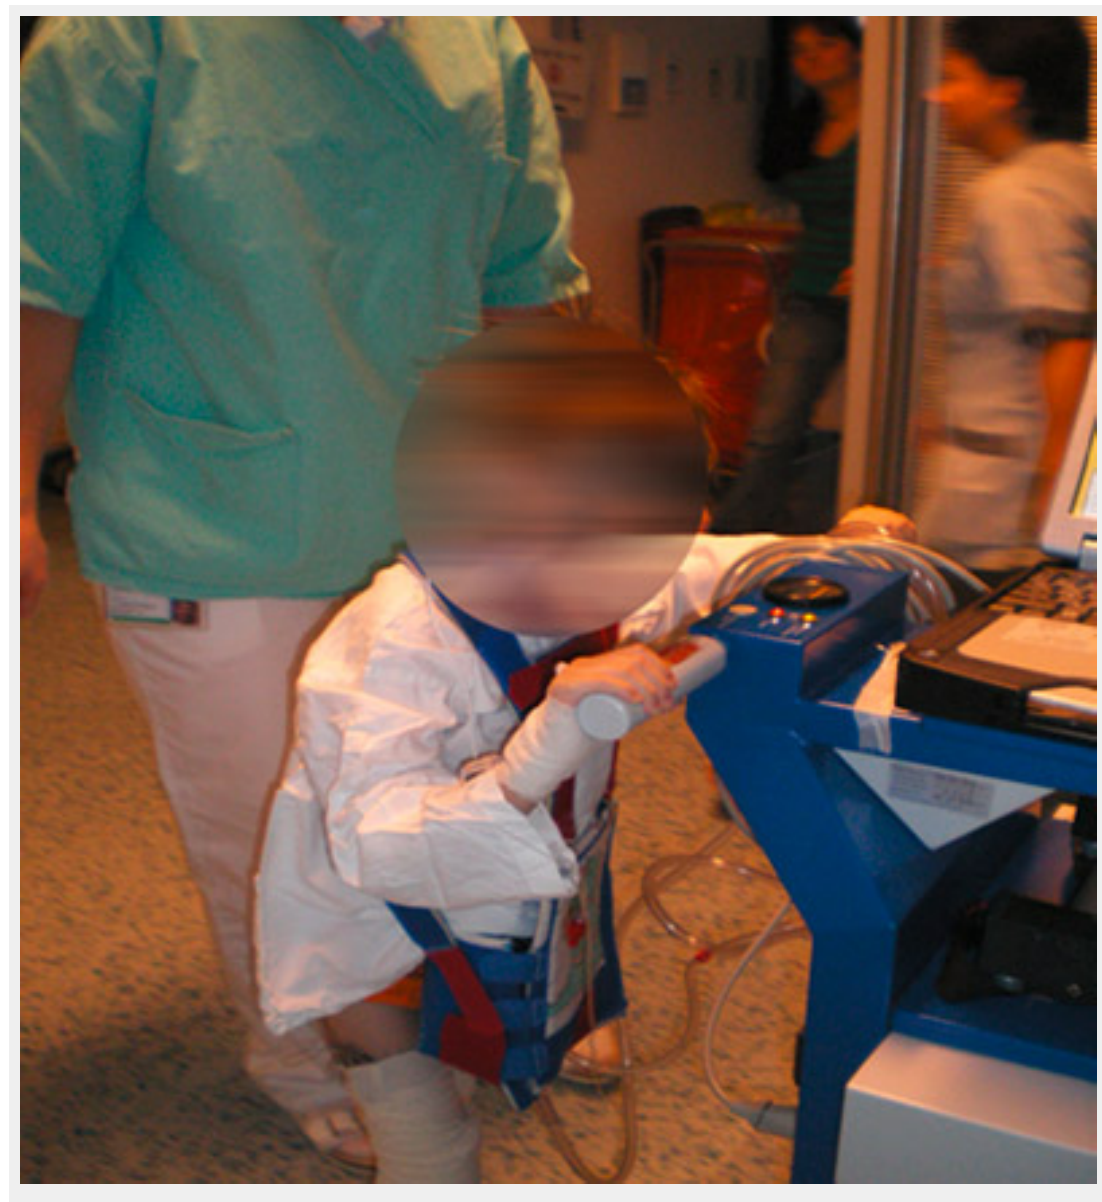
Figure 2 The Berlin Heart Excor is suitable for children of all sizes and with biventricular